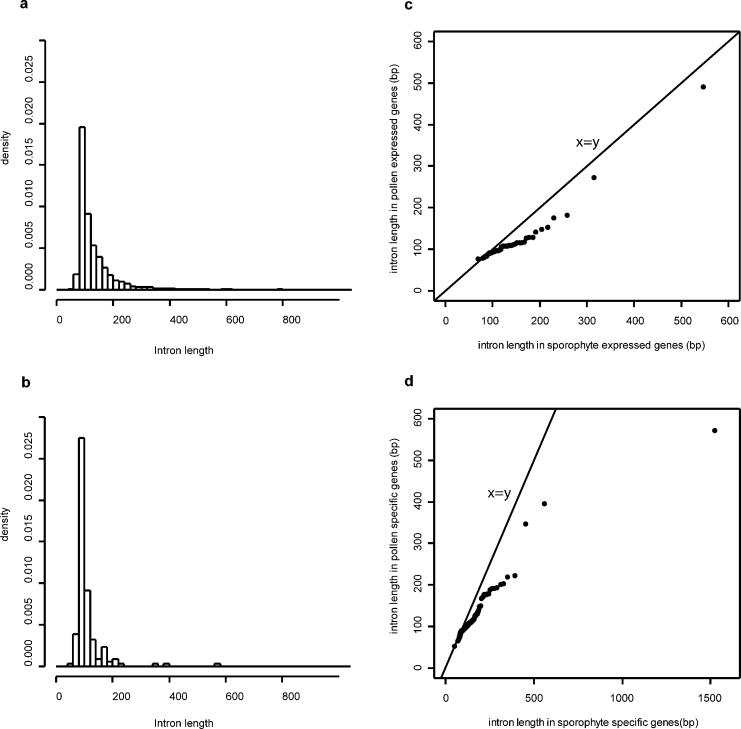
Histograms and Quantile–Quantile Plots of Mean Distal Intron Length(A) Histogram for genes expressed in the sporophyte microarray datasets.(B) Histogram for genes expressed in the gametophyte but not the sporophyte microarray datasets.(C) Quantile–quantile plot of introns from all pollen-expressed and all sporophyte-expressed genes derived from the SAGE dataset. Quantiles of the intron length distributions for genes expressed in the gametophyte and sporophyte are on the x- and y-axes, respectively.(D) Quantile–quantile plot of introns from pollen-specific and sporophyte-specific genes derived from the microarray dataset.